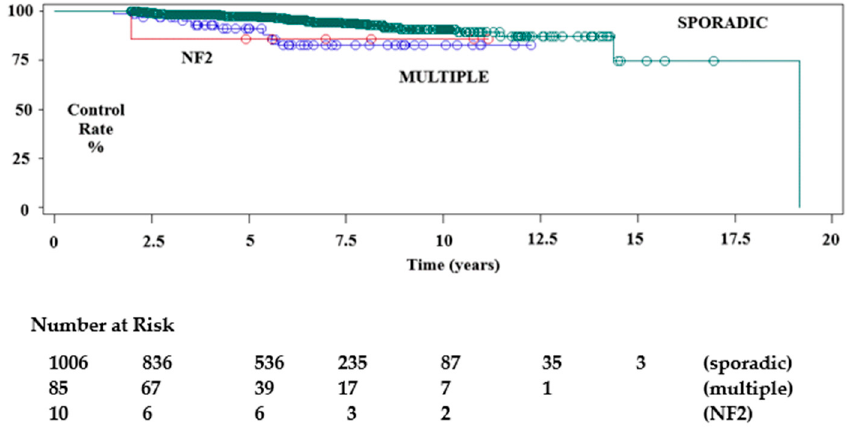
Figure 4. Kaplan–Meier test showing local imaging tumour control after SRS plotted by number of meningiomas treated.